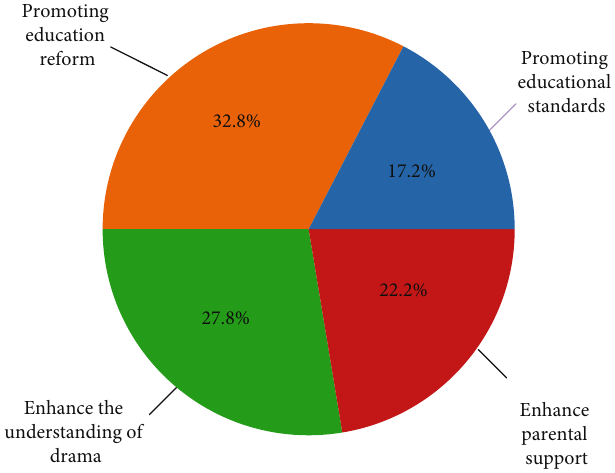
Figure 5: Advantages of learning drama in human-computer interaction